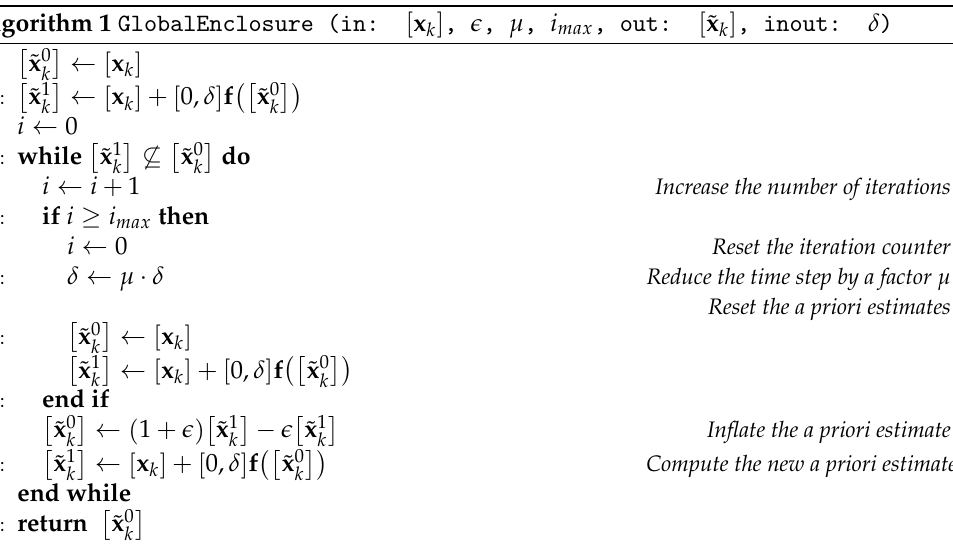
Figure 8. First order enclosure algorithm. ( a ) First iteration: (cid:2)